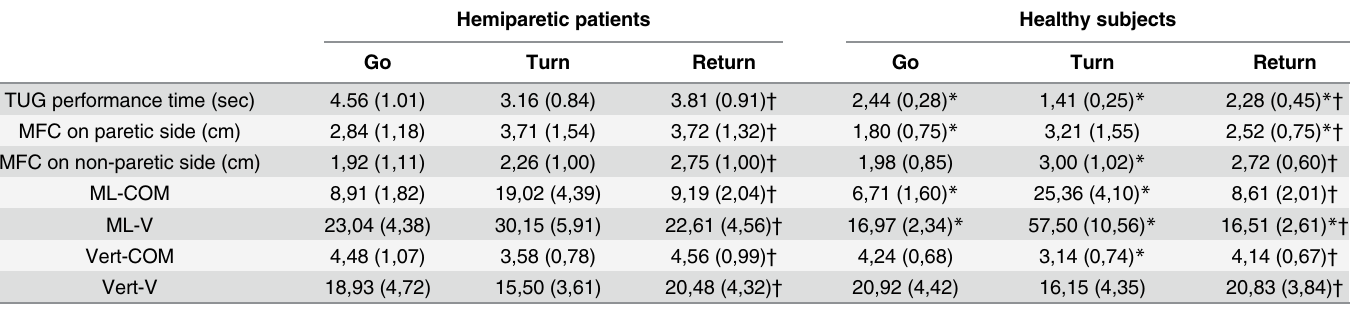
Table 2. TUG performance, COM parameters and foot clearance in hemiparetic patients and healthy subjects during Go, Turn and Return sub- tasks. Hemiparetic patients Healthy subjects